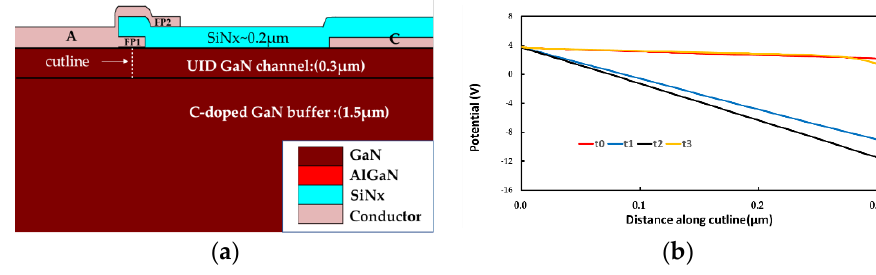
Figure 8. Schematic of ( a ) the cutline location; ( b ) the potential at different timings.